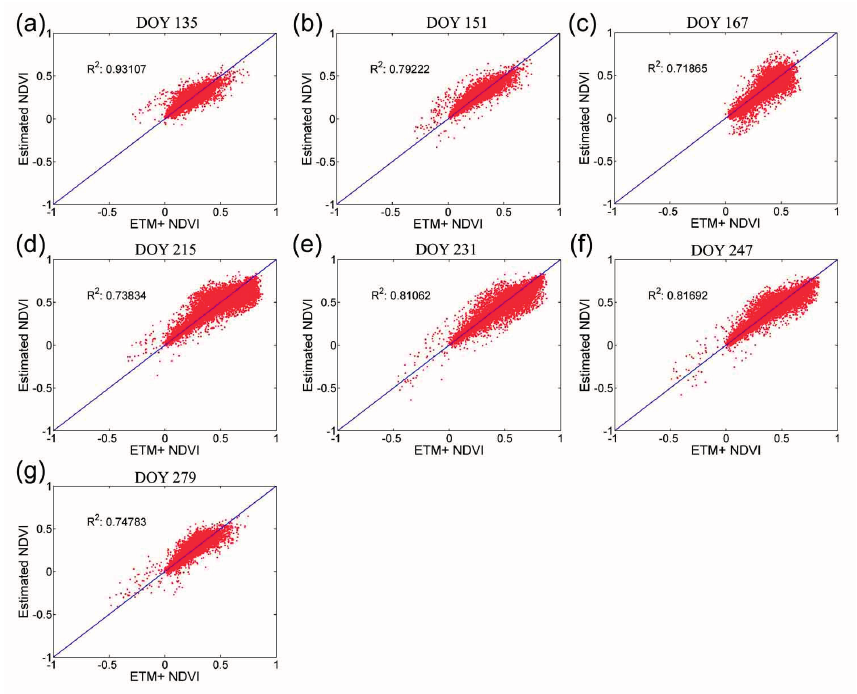
Figure 10. Scatterplots of the predicted NDVI and the actual ETM+ NDVI for the 134_32/33 sub-area. (Predicted NDVI by blending MODIS and ETM+ data of: ( a ) DOY 119, DOY 151; ( b ) DOY 135, DOY 167; ( c ) DOY 151, DOY 215; ( d ) DOY 167, DOY 231; ( e ) DOY 215, DOY 247; ( f ) DOY 231, DOY 279; ( g ) DOY 247, DOY